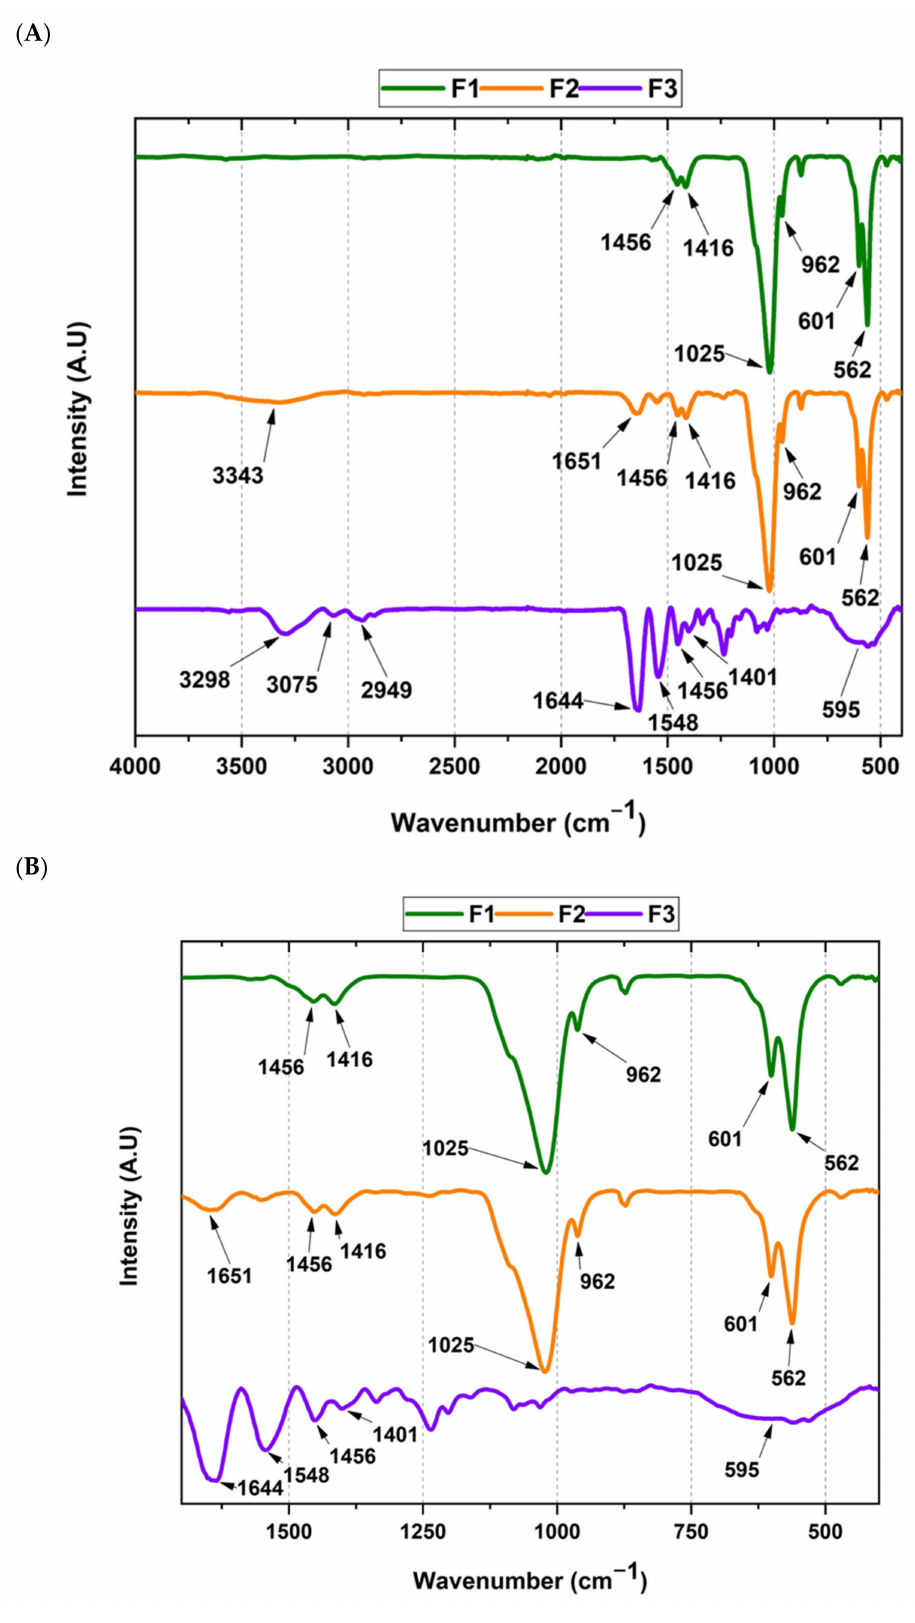
Figure 1. ( A ) FT-IR spectrum of the xenografts and collagen membrane. ( B ) Expanded 600–1700 cm − 1 region of the FT-IR spectrum. F1: InterOss. F2: InterOss Collagen. F3: InterCollagen